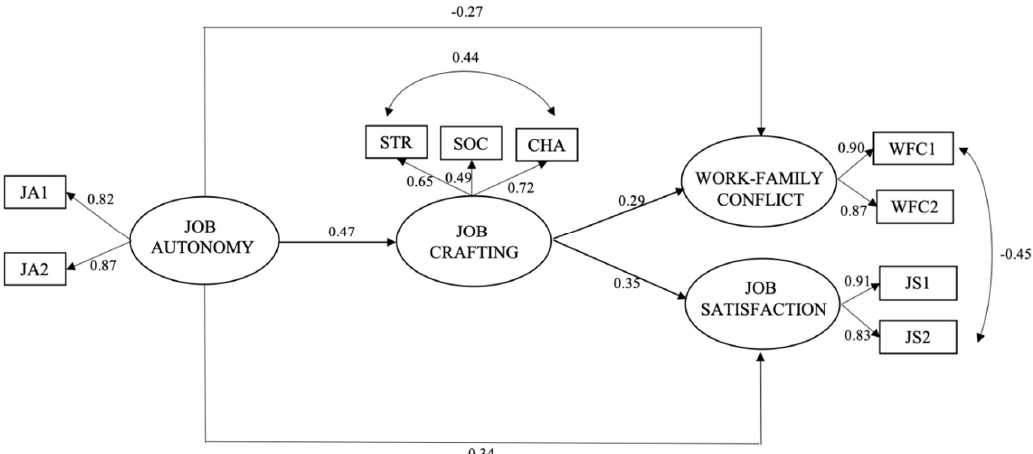
Figure 1. Results of the structural equations model. Note. STR = increasing structural job resources;